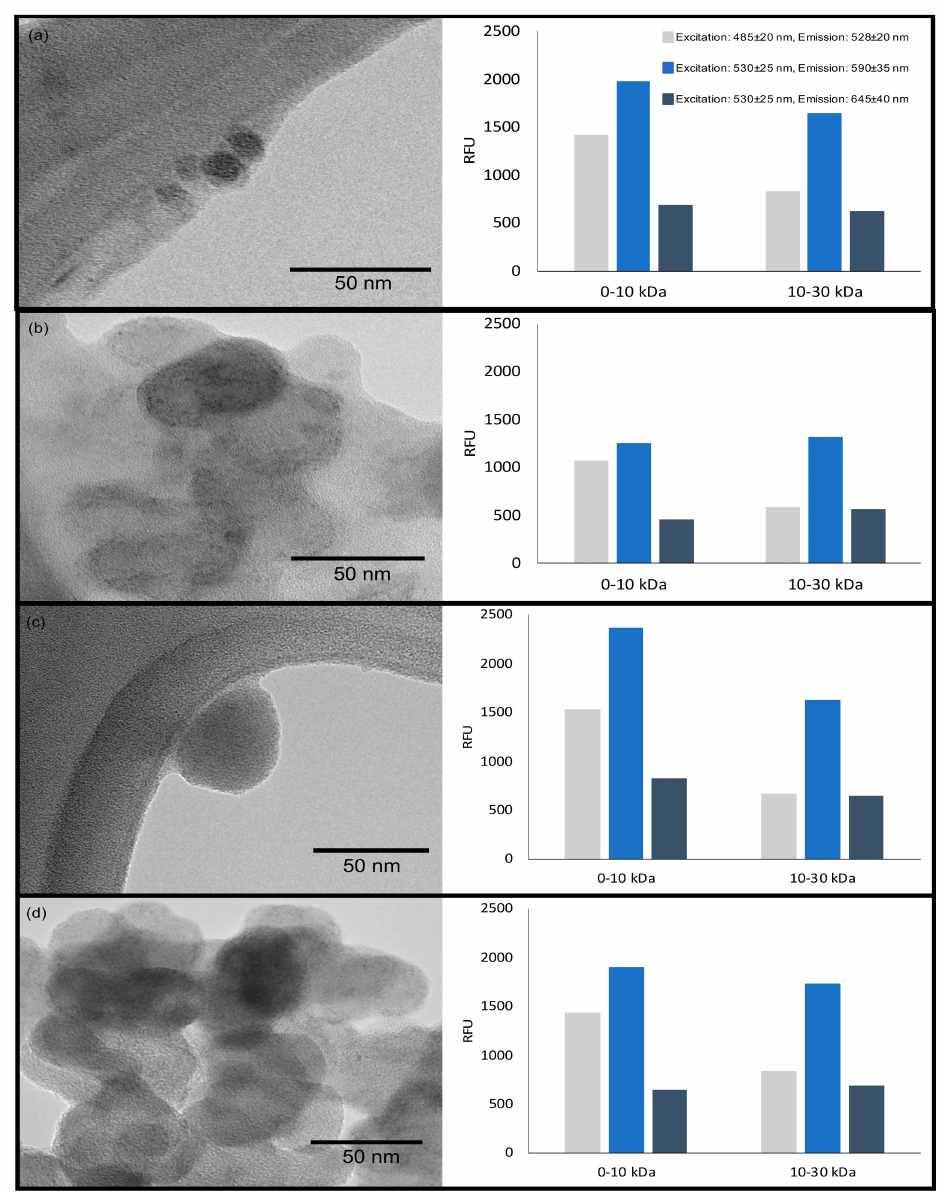
Figure 8. Transmission electron microscopy (TEM) images from ( a ) carbon dots from CB, ( b ) carbon dots from CB.H 2 SO 4 , ( c ) carbon dots from CB.KOH, and ( d ) carbon dots from CB.H 2 SO 4 + KOH. The bar plots show the mean relative fluorescence units (RFU) at di ff erent emission ranges of carbon dots from fraction 0 to 10 kDa and 10 to 30 kDa. Note: Water was used as a control for fluorescence measurements; the maximum di ff erence between the replicas was 101